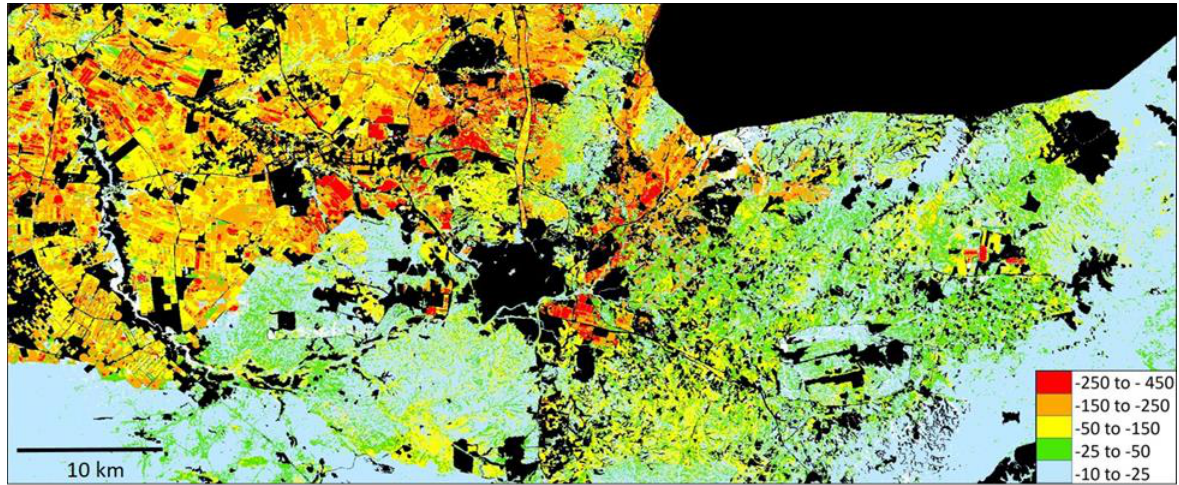
Figure 4. Degradation measured by Local NPP Scaling (LNS), by calculation of the difference between actual and potential LNS (NPP obs -NPP pot , in gC m − 2 yr − 1 (Figure 3). The more negative the value, the greater the reduction in NPP.